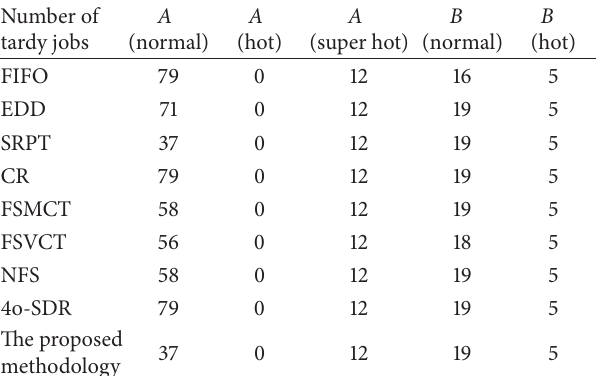
Table 7: The performance levels of various approaches for number of tardy